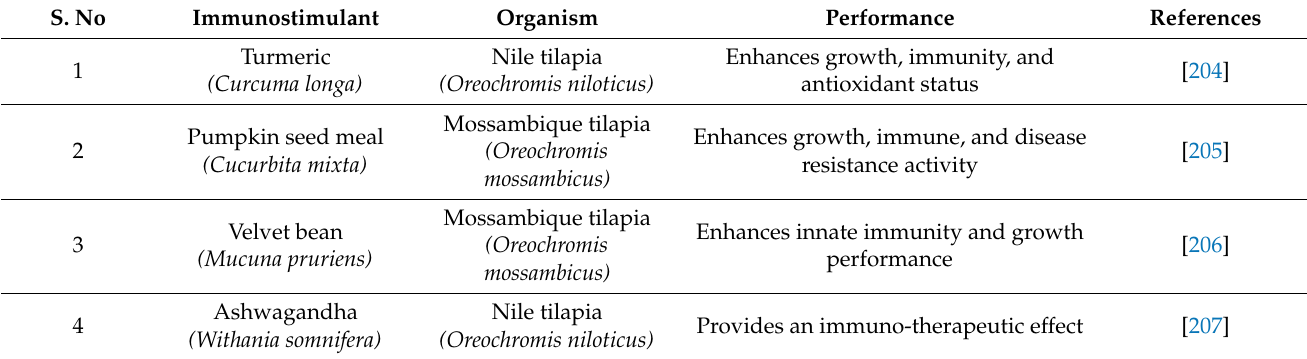
Table 4. Usage of herbal immunostimulants in tilapia